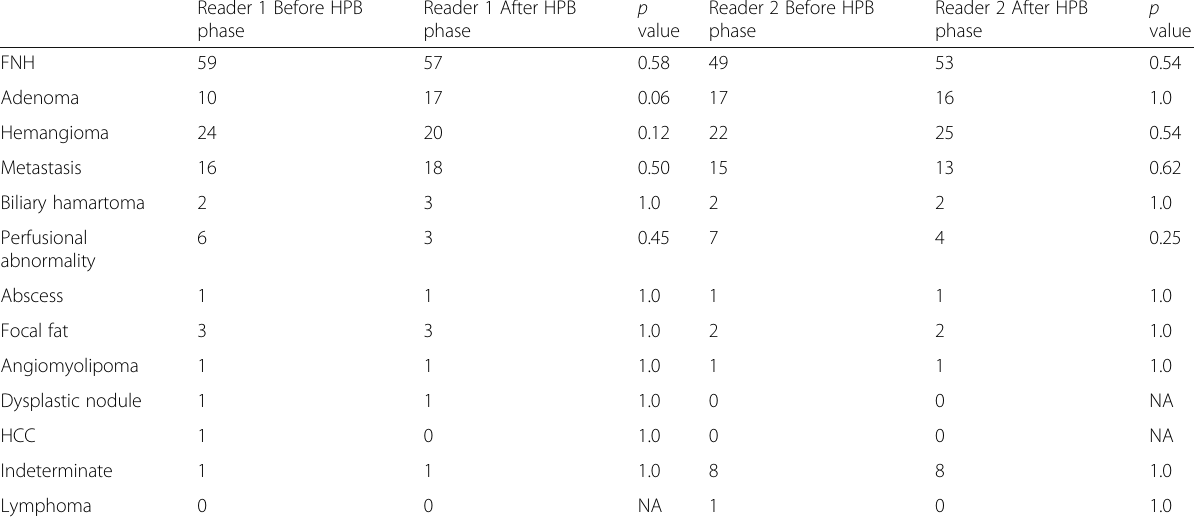
Table 3 Reader characterization of lesions before and after evaluation of the HPB phase and change in confidence Reader 1 Before HPB